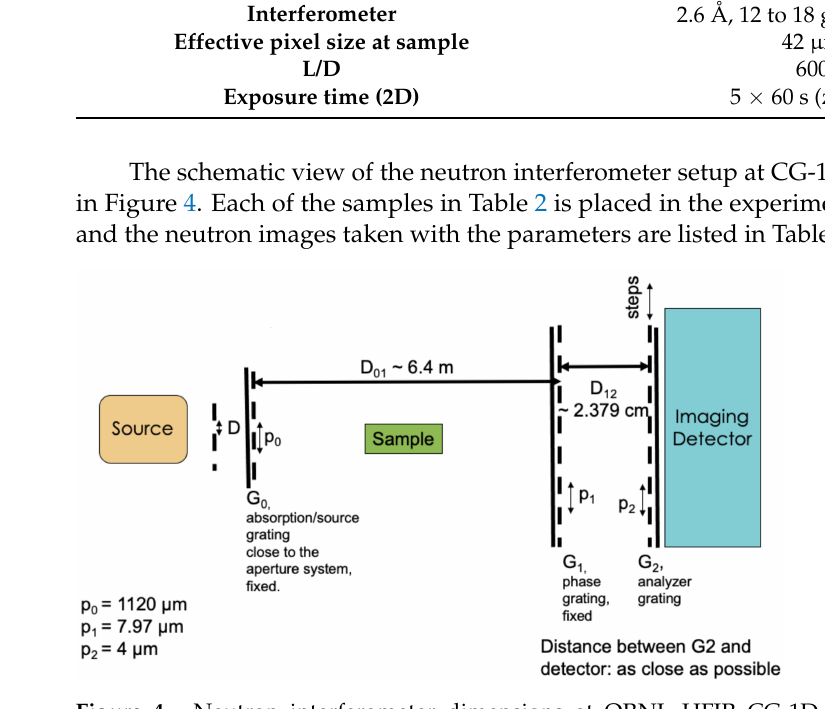
Figure 4. Neutron interferometer dimensions at ORNL HFIR CG-1D beamline (courtesy of Dr. Hassina Bilheux, ORNL Neutron Sciences Directorate).